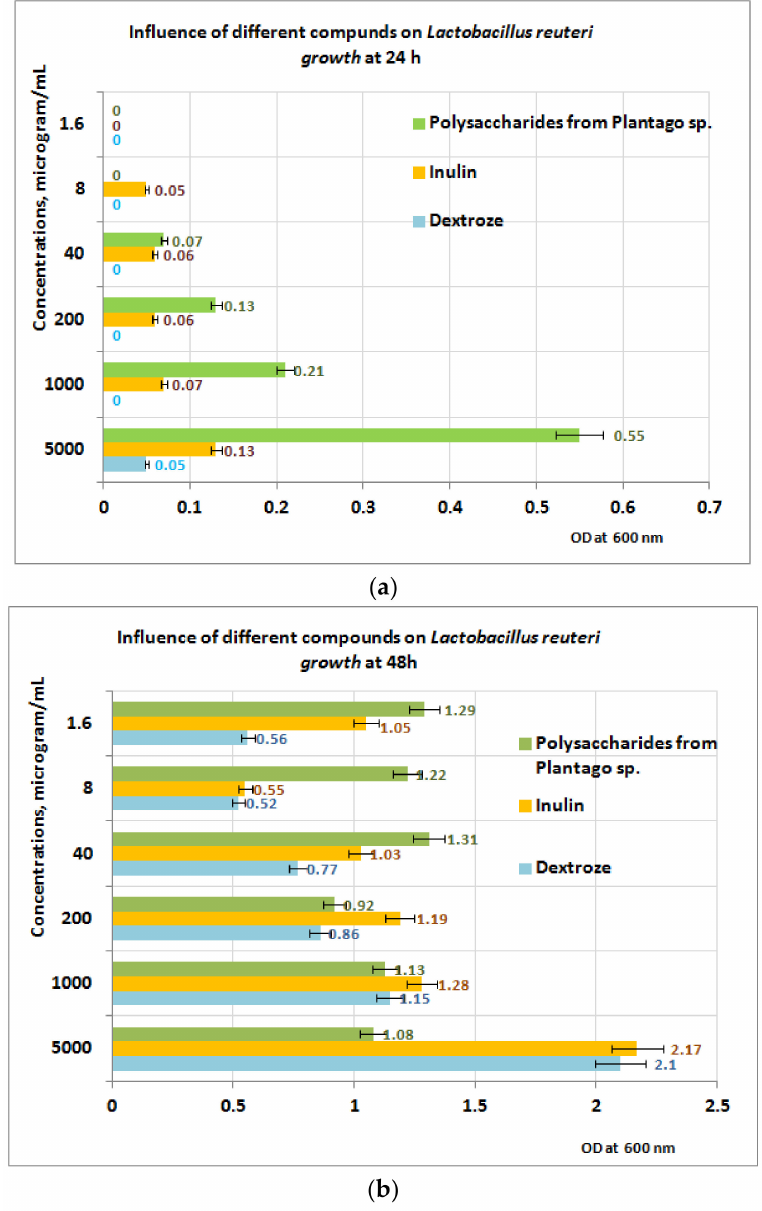
Figure 9. ( a ) Influence of PP on L. reuteri growth at 24 h. ( b ) Influence of PP on L. reuteri growth at 48